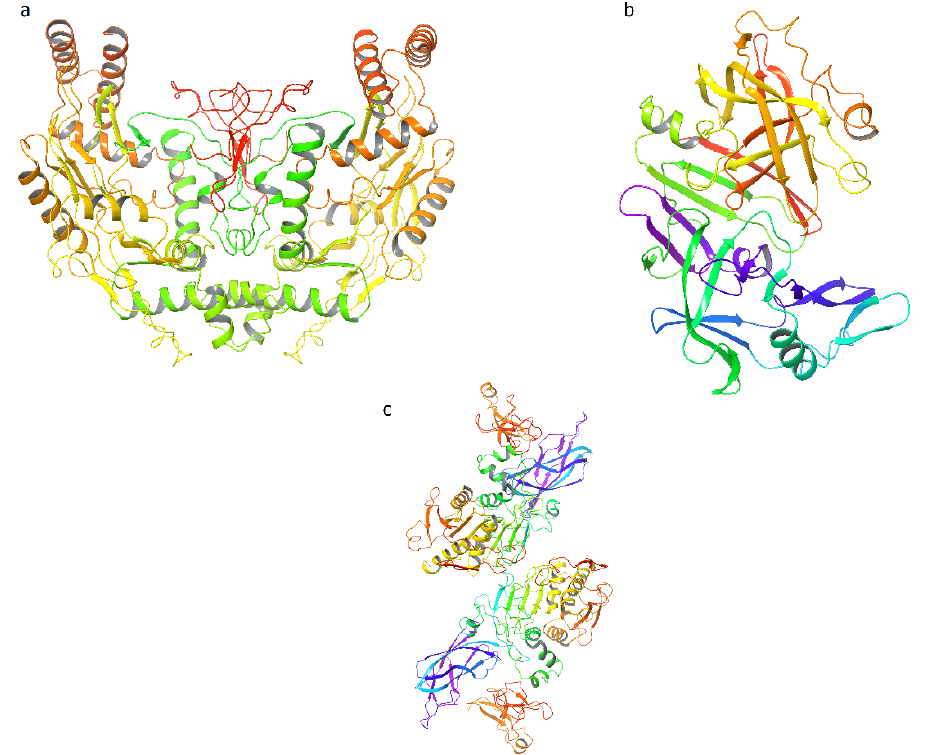
Figure 2. Targets studied about Phaseolus vulgaris . ( a ) NOS protein (PDB:ID 3NLE) [237]. ( b ) Porcine gastric mucosa (PDB code: 5PEP [240]. ( c ) Porcine pancreatic lipase (PDB code: 1 ETH) [241]. Source: adapted images according to PDB ID.